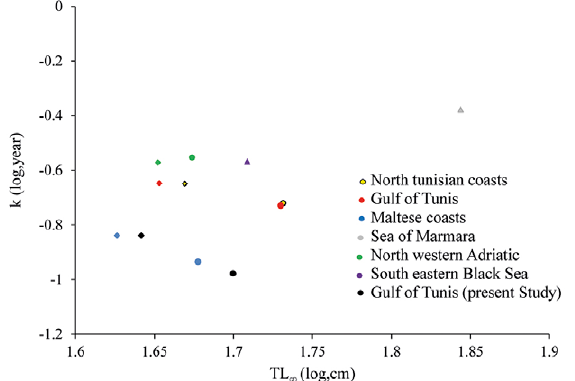
Fig. 7. – Auximetric grid showing the relationship performance of Sciaena umbra from different areas. The different studies are indicated with different colour. Growth performance of males are represented by diamonds, females by circles and combined sex by